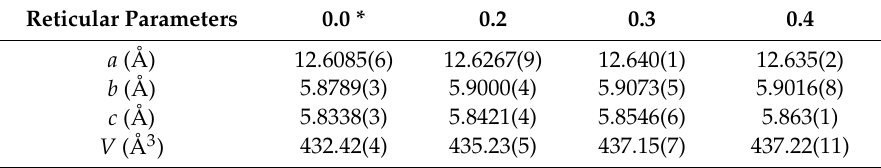
Figure 1. XRD patterns of the materials of the series La 1.2 Sr 0.8 − x Ba x InO 4+ δ , collected with CuK α radiation. The stars correspond to La 2 O 3 impurity phase. Table 1. Unit-cell parameters and volume at room temperature for La 1.2 Sr 0.8–x Ba x InO 4 .